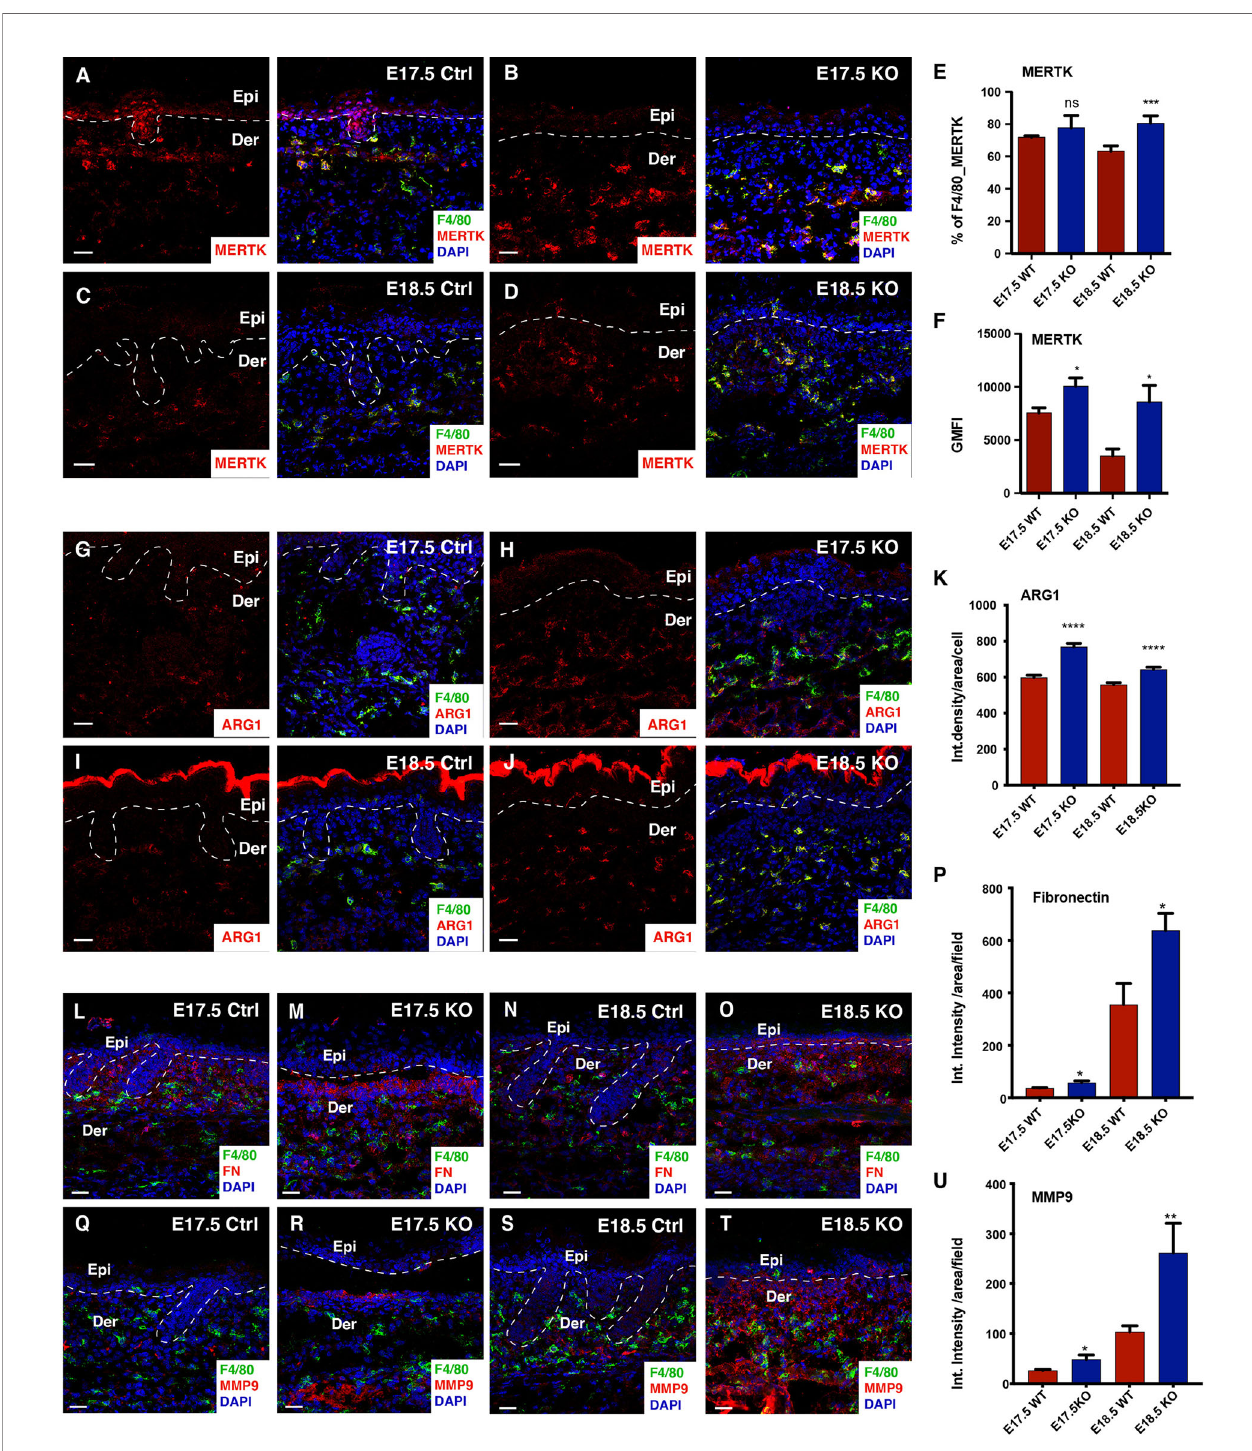
FIGURE 3 | Macrophages in the KO skin acquire exaggerated M2-like pro-remodelling properties at E18.5. Immunostaining in the control and Itg b 1 epidermal KO skin at E17.5 and E18.5 for F4/80 and MERTK (A – D) quanti fi ed in (E) (N=3). Surface level expression of MERTK is quanti fi ed (F) (N=3). Immunostaining in the control and Itg b 1 epidermal KO skin at E17.5 and E18.5 for F4/80 and Arg1 (G – J) quanti fi ed in (K) (N=2). Immunostaining in the control and Itg b 1 epidermal KO skin at E17.5 and E18.5 for F4/80 and FN1 (L – O) quanti fi ed in (P) (N=2). Immunostaining in the control and Itg b 1 epidermal KO skin at E17.5 and E18.5 for F4/80 and MMP9 (Q – T) quanti fi ed in (U) (N=2). The white dashed line separates the epidermis (Epi) and the dermis (Der). Scale bars: 20 um. (*p ≤ 0.05, **p ≤ 0.01, ***p ≤ 0.001, ****p ≤ 0.0001, ns=not signi fi